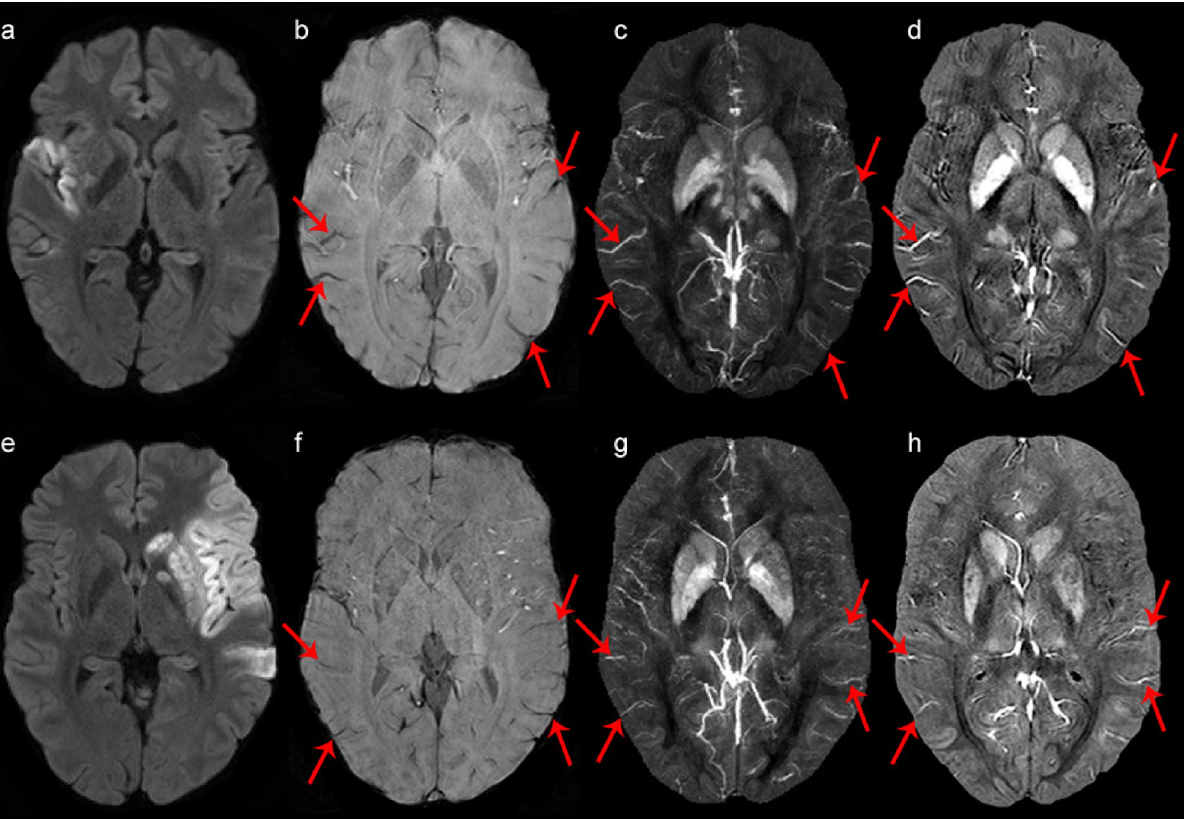
Figure 3. Comparison of DWI, SWI, MIP and QSM in 2 different patients for cortical vein identification. ( a – d ) represent one patient while ( e – h ) represent another patient. Image ( a ) and ( e ) demonstrate the ischemic core of the ischemic hemisphere, which is hyperintense on DWI. A selection of cortical veins (red arrows) is demonstrated on SWI ( b and f ), MIP ( c and g ) and QSM ( d and h ) in control and ischemic hemisphere.